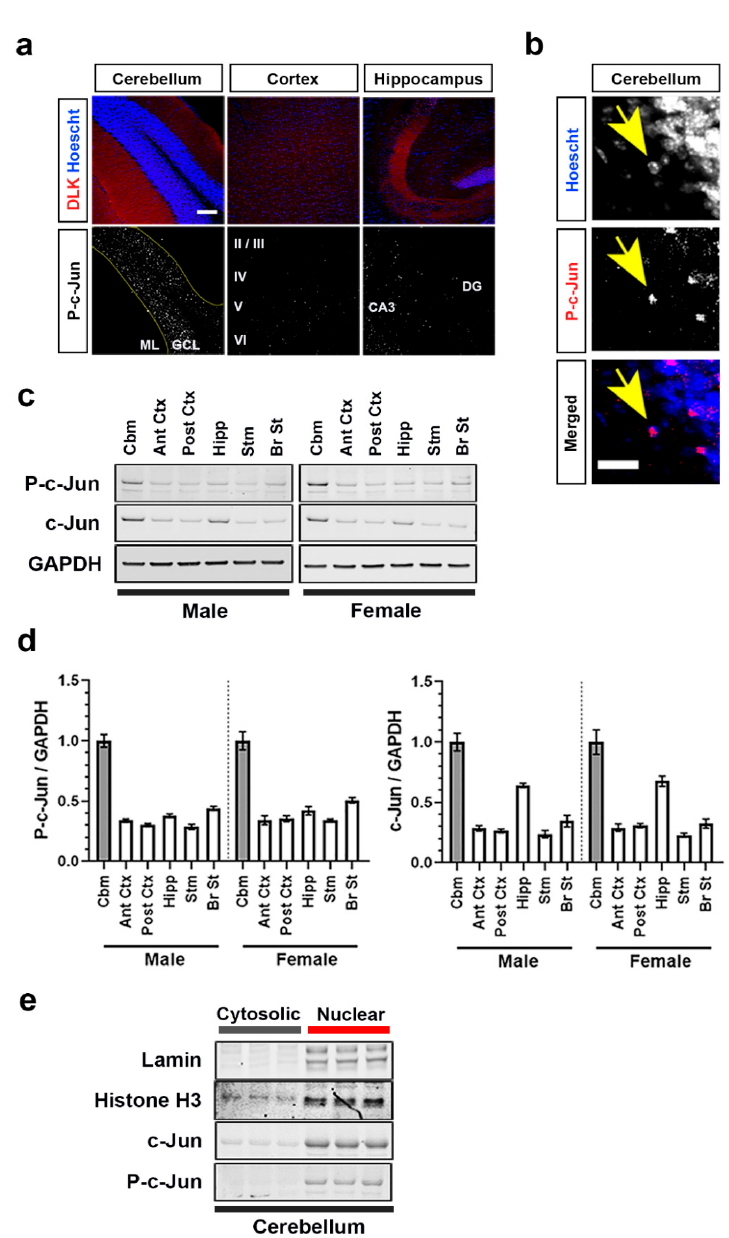
Figure 2. Dual leucine zipper kinase (DLK), p-c-Jun, and c-Jun expression in adult uninjured mouse brain. ( a ) Representative double staining for DLK (red) and Hoechst (blue) shows DLK’s distribution in the molecular layer of the cerebellum, diffusely throughout the cortex and in the mossy fiber axon terminals in the hippocampus of 3–4 months old male wild-type (WT) mouse brain. Representative staining for p-c-Jun shows its distribution in the granule cell layer of the cerebellum, in layer V of the cortex and to a lesser degree in the CA3 region of the hippocampus. GCL, granule cell layer; ML, molecular layer; CA3, Cornu Ammonis subfield 3 of the hippocampus; DG, dentate gyrus. Scale bar: 100 µm. ( b ) p-c-Jun (red) fluorescence overlaps with Hoechst (blue)-positive nuclei, indicating a nuclear localization. Scale bar: 20 µm. ( c ) Immunoblots of p-c-Jun and c-Jun in lysates obtained from cerebellum (Cbm), anterior cortex (Ant Ctx), posterior cortex (Post Ctx), hippocampus (Hipp), striatum (Stm), and brainstem (Br St) of 3–4 months old male and female WT mice. ( d ) Quantification of p-c-Jun / GAPDH and c-Jun / GAPDH immunoblots in (c) (represented as fold change relative to cerebellar levels). ( e ) Immunoblots of Lamin, Histone H3, p-c-Jun, and c-Jun in cytosolic and nuclear fractions of 3–4 months old male WT mice